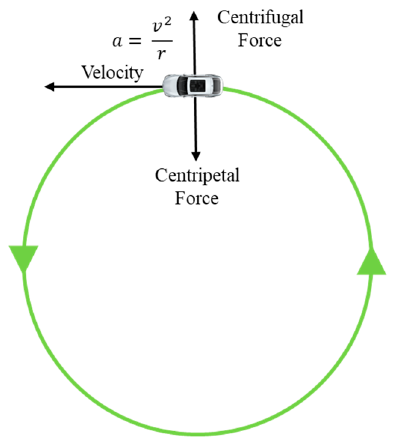
Figure 10. Centrifugal force when a car goes around a curve.